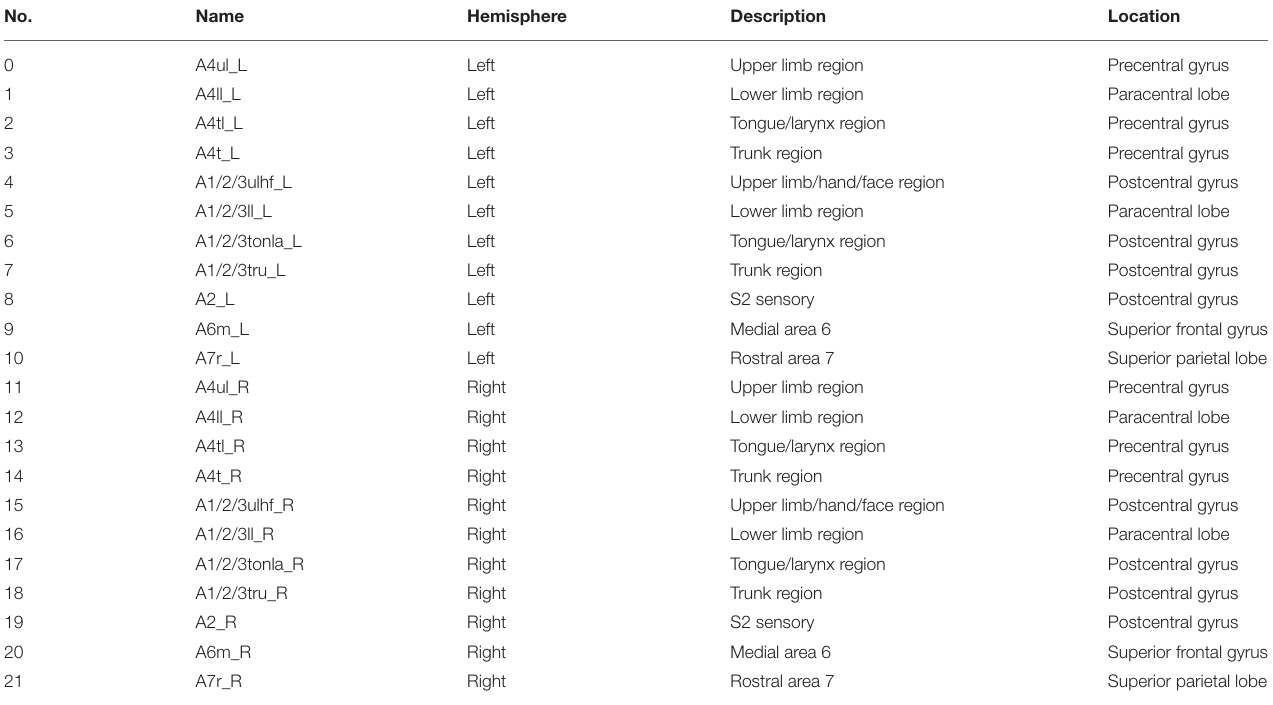
TABLE 2 | Information of 22 ROIs based on Brainnetome Atlas. No.